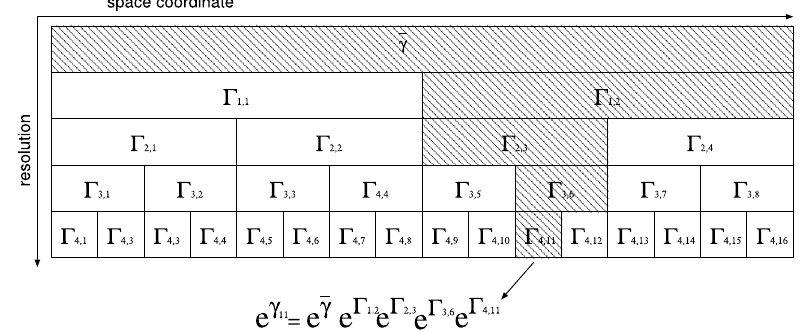
Figure 3. Schematic of the multiplicative cascade model. The energy dissipation rate at z 11 at resolution r 4 = L / 2 4 is considered as an